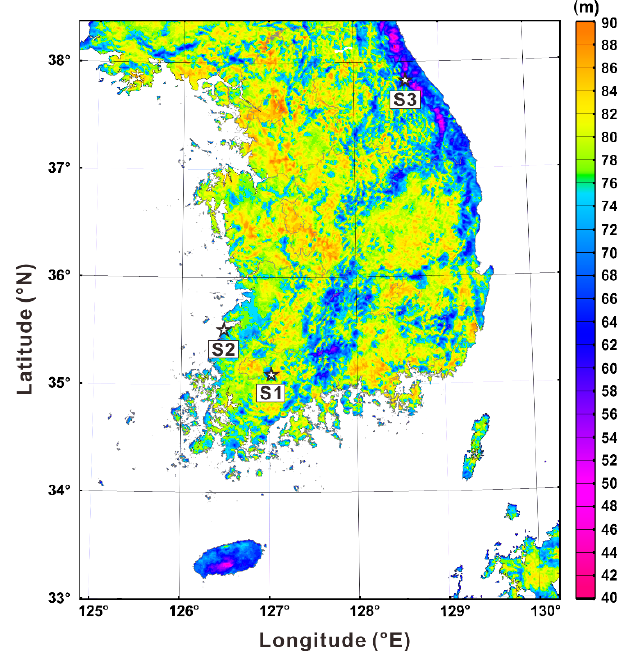
Figure 5. Distribution of optimal hub height for WT0.